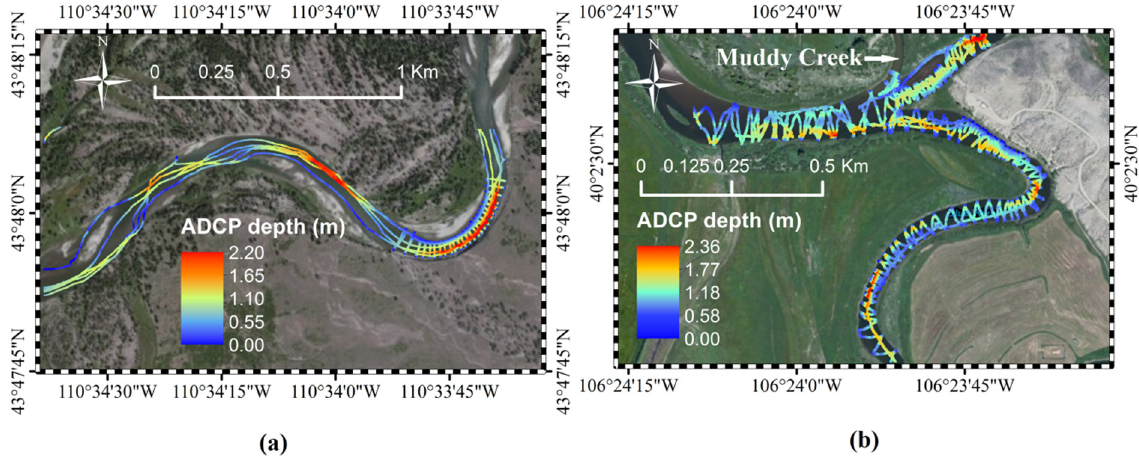
Figure 5. Study areas, ( a ) Overview of the Snake River with ADCP profiles locations highlighted and colored by depth. ( b ) Overview of the Blue/Colorado River study area, the circled area is turbid plume from Muddy Creek; Colorado River flows from east to west in the image and the Blue River enters the channel from the south. The ADCP profiles locations are highlighted and colored by